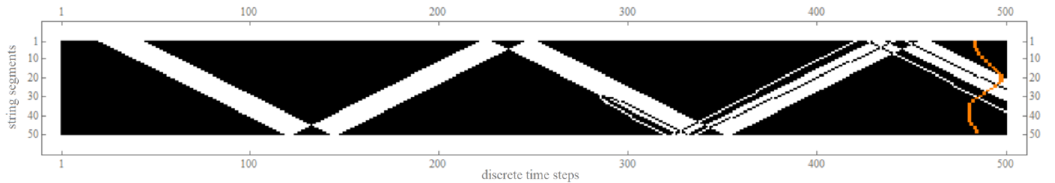
Figure 14 . The parameters of the simulation are N kink = 100 , ∆ t = 8 , and (cid:15) = 0 . 095 . The orange curve is a Poincaré timeslice. The corresponding string embedding is shown in figure